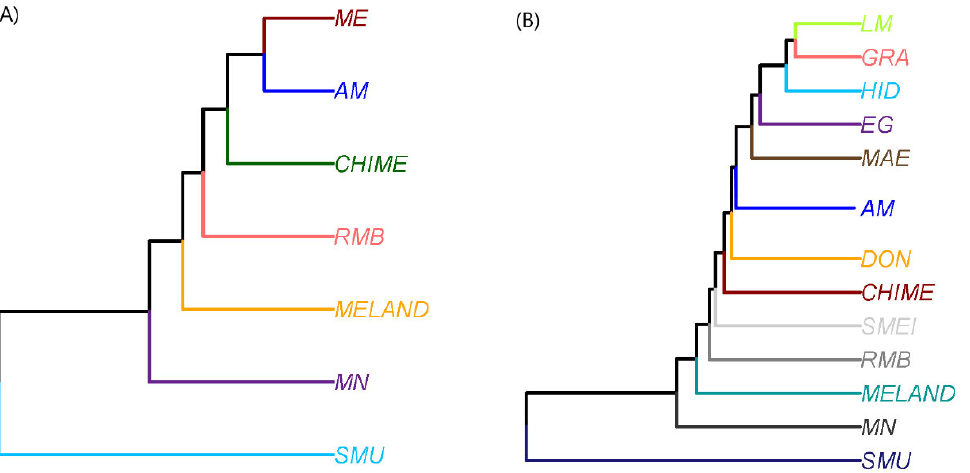
Figure 6. ( A ) Pop tree of the different breeds and mouflon as the outgroup control using genomic phylogenetic analysis. ( B ) Pop tree of the different breeds and mouflon as the outgroup control using genomic phylogenetic analysis. Tree generated with the genetic distances of NEI using the UPGMA method. Breeds: AM (Australian Merino), CHIME (Chinese Merino), ME Spanish Merino, MELAND (Landschaft Merino), RMB (Merino of Rambouillet), MN (Spanish Black Merino). Genetic lines within the Spanish Merino: DON (Donoso), EG (Egea), GRA (Granda), HID (Hidalgo), MAE (Maesso), LM (López ‐ Montenegro), SMEI (Spanish Merino from Industrial Breeding). Outgroup species: SMU (Mouflon).